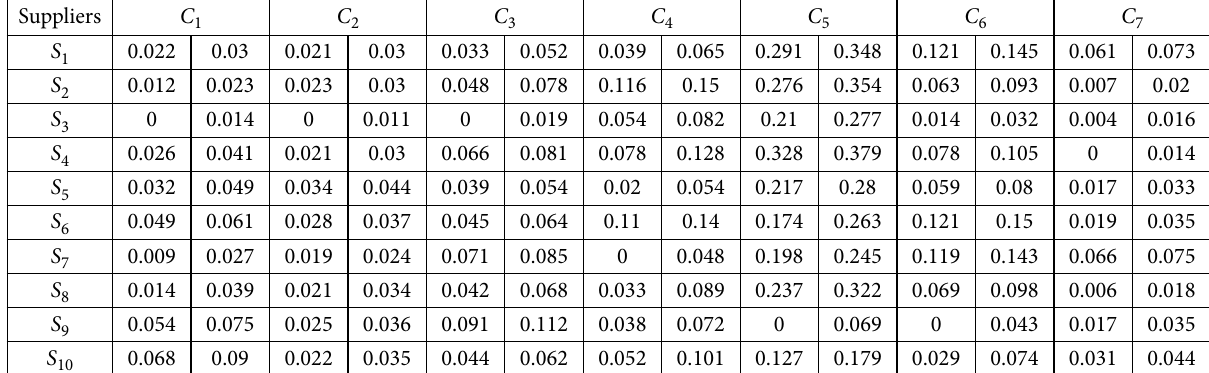
Table 11. The weighted normalized decision matrix for suppliers